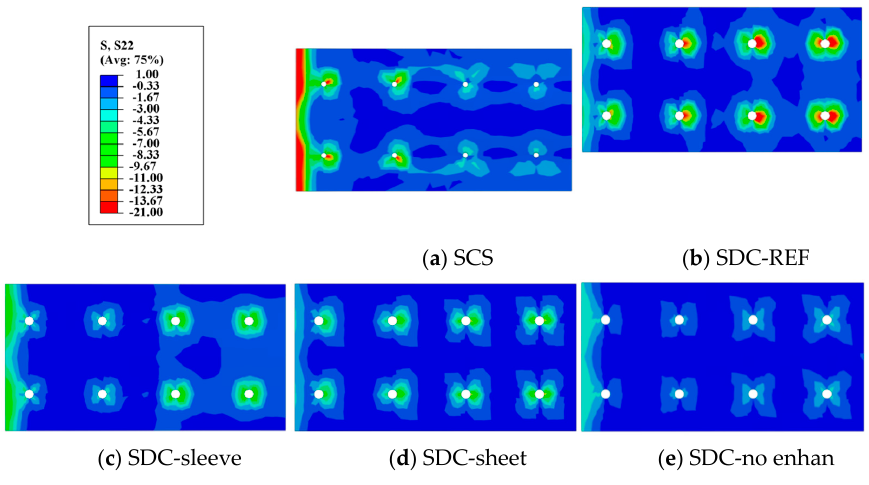
Figure 13. The lateral stress (S22) of the concrete core of SDC walls.